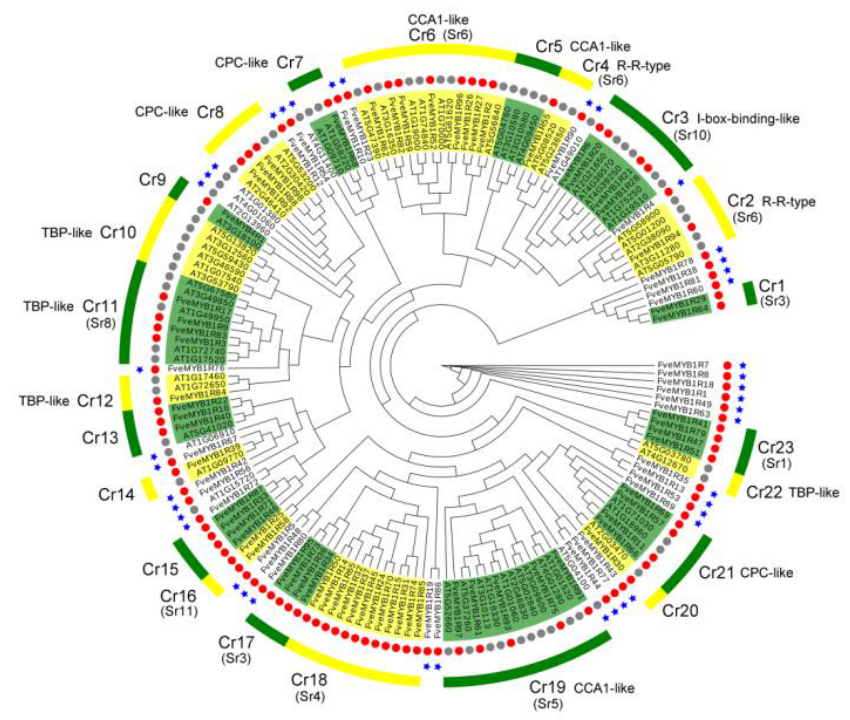
Figure 4. The phylogenetic tree of 1R-MYB and 4R-MYB proteins from woodland strawberry and Arabidopsis . According to previous study in soybean [26], the phylogenetic tree was divided into 23 phylogenetic clades (Cr1 – Cr23) based on bootstrap values (>50). Red dots represent MYB proteins from woodland strawberry. Grey dots represent MYB proteins from Arabidopsis . Blue stars represent MYB proteins from woodland strawberry not fit into any clades (bootstrap support values <50). Sr1 – Sr14 are group numbers of strawberry 1R-MYB and 4R-MYB proteins named in Figure 2. The function of some members from Arabidopsis was annotated outside the circle.